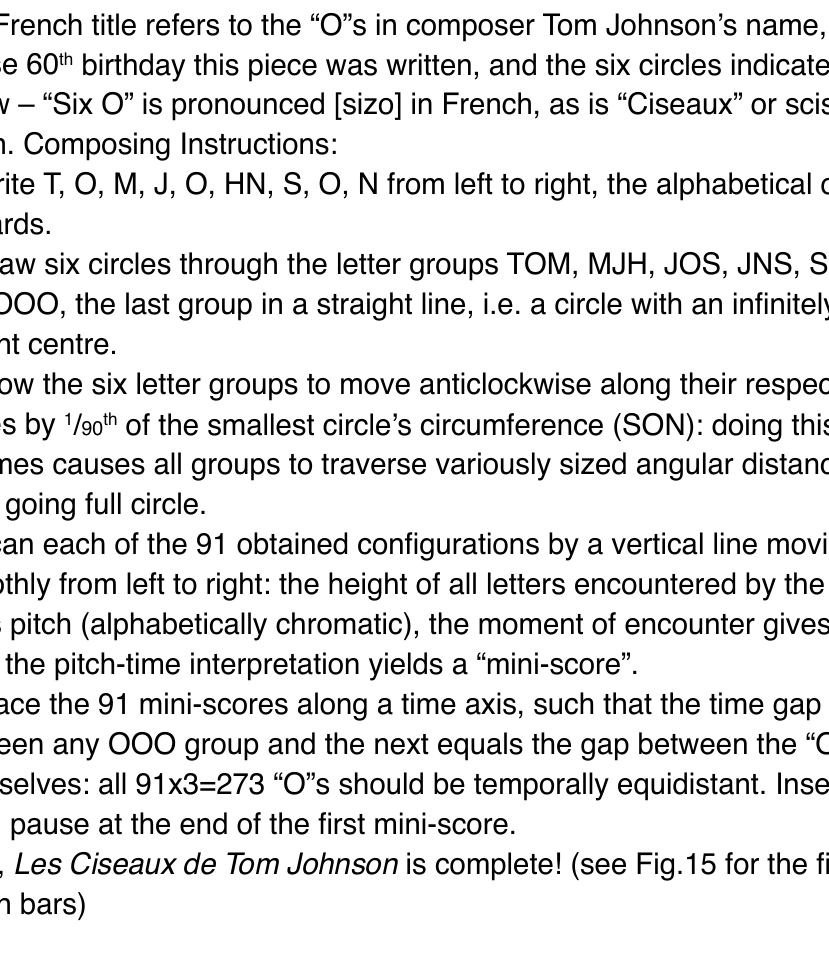
Figure 14: MIDI pitch-time maps of Kuri Suti Bekar: left box the Prelude, right box the ten pages of the Chaconne shown individually (below) and superimposed (top centre right).